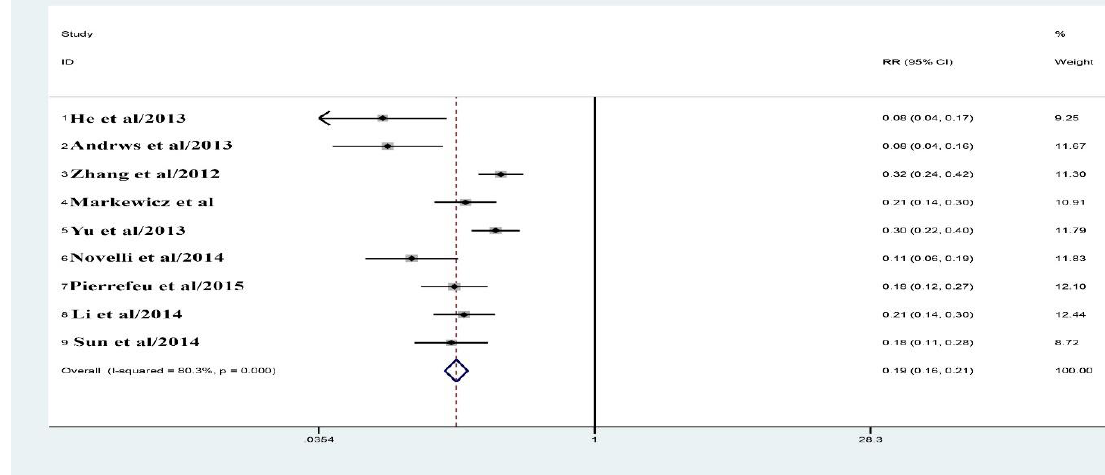
Figure 2. Forest plots with regard to the surgical navigation and trauma surgeries. Heterogeneity chi-squared = 40.55 (df. = 8) p=0.000. I-squared (variation in the RR attributed to heterogeneity) = 80.3%. RR Test = 1:z= 23.91